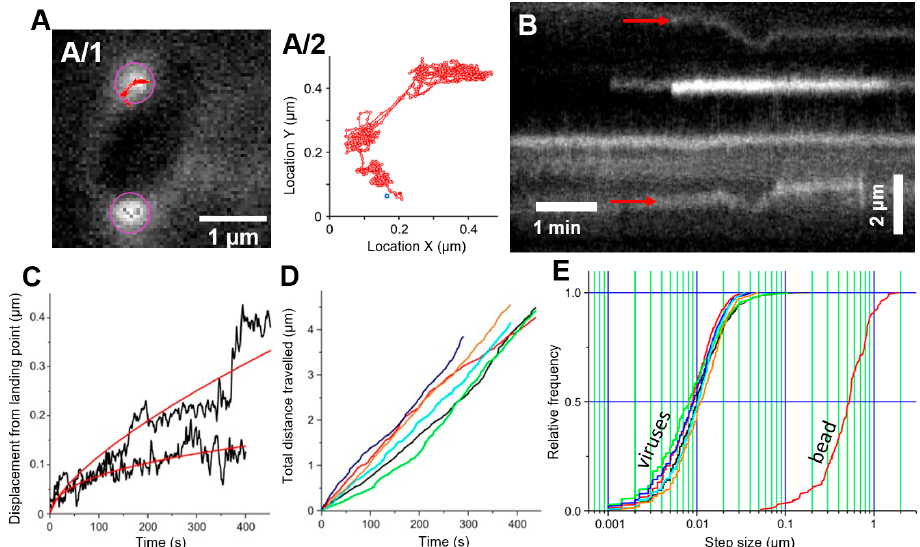
Figure 2. Phages travel on the bacterial surface. ( A ) Bacteriophages searching on the surface of a bacterium: ( A/1 ) Purple circles show tracked particles, the red line shows the trajectory of the upper particle. ( A/2 ) Enlarged graph of the trajectory shown in ( A/1 ), the blue spot shows the initial binding point. ( B ) Kymogram of bacteriophages traveling along the bacterial periphery. Kymograms have been created from the elliptical periphery of individual bacteria (indicated by a white dashed line in Figure 3A). Red arrows show the initial docking position of two phages. ( C ) Black curves show the distance of two tracked viruses from their landing point over time, the red line shows a parabolic function fitted to the data with exponents of 0.64 and 0.43. ( D ) Total distance traveled by tracked phages from their initial binding point. Different colors correspond to different viruses. ( E ) Step size distribution of bacteriophages, and a 60 nm diameter bead. When comparing the step size distributions of viruses and that of the bead, it must be noted that the movement of phages was recorded at 1 frame per second, while the movement of beads was recorded at 10 frames per second.